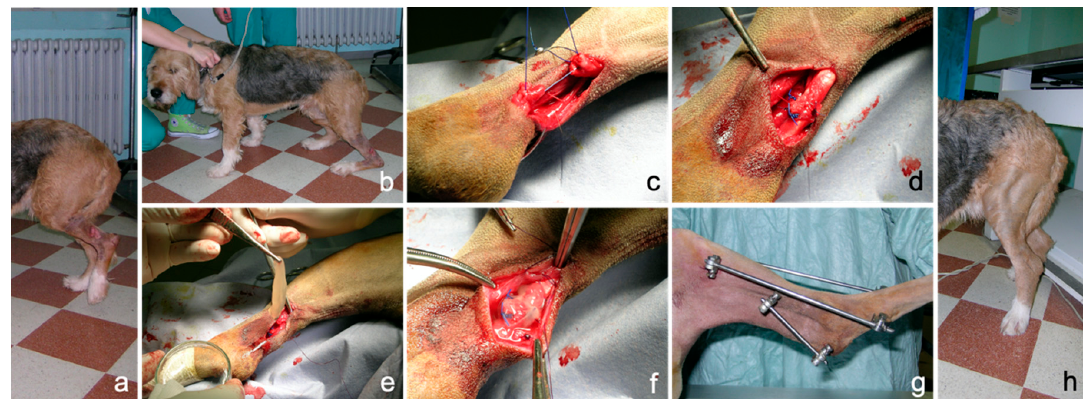
Figure 7. Complete rupture of the common calcaneal tendon (Achille tendon) in a dog following direct sharp trauma. ( a ): condition at presentation showing a deep wound at the tibial diaphyseal region and complete hind limb load sparing in standing position; ( b ): plantigrade posture during weight